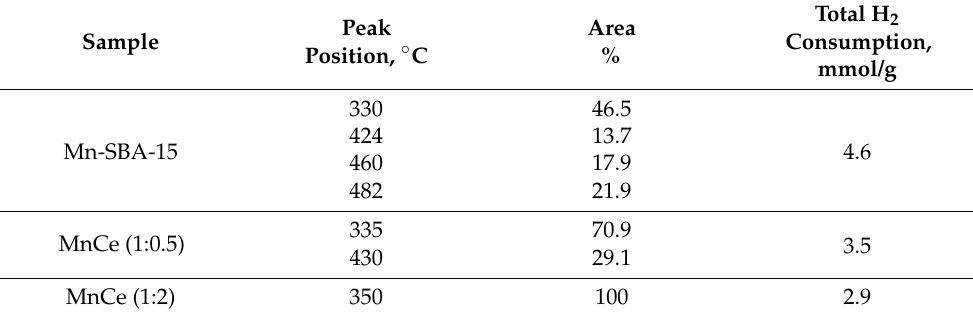
Table 4. Peak areas after deconvolution of TPR